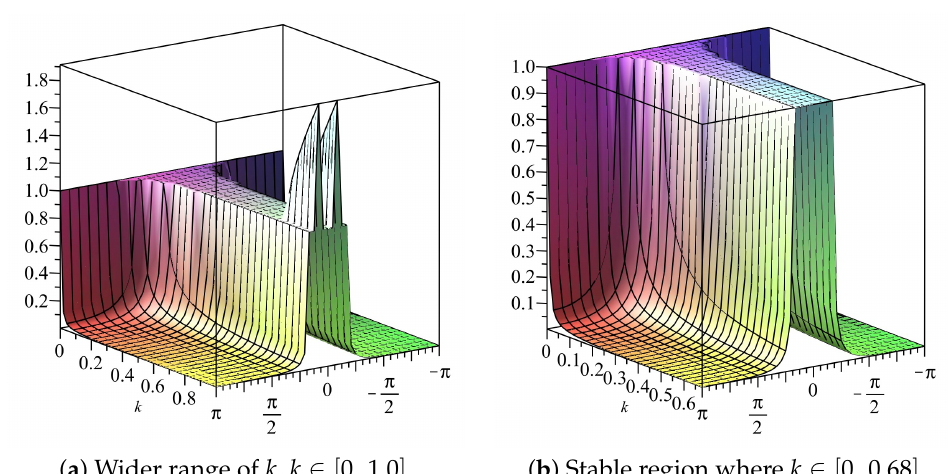
Figure 6. Plot of | ξ 1 | vs. k vs. w ∈ [ − π , π ] of Scheme 2 for Numerical Experiment 1. The spatial step size h = π /10.